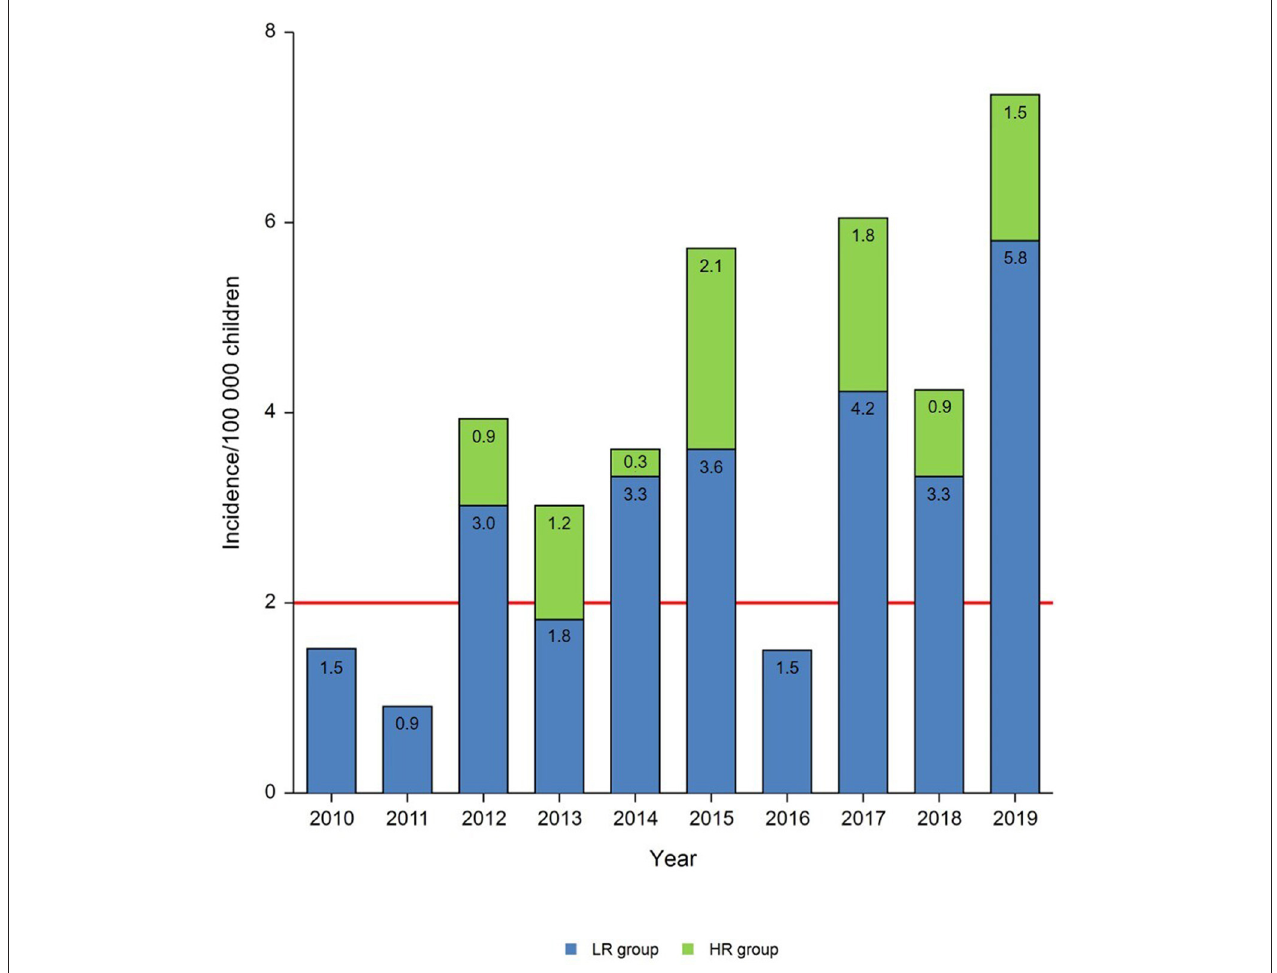
FIGURE 2 | Annual incidence rates of patients with ARF per 100,000 children. The red line indicates the threshold value of incidence which differentiates low-risk from moderate and high-risk populations.